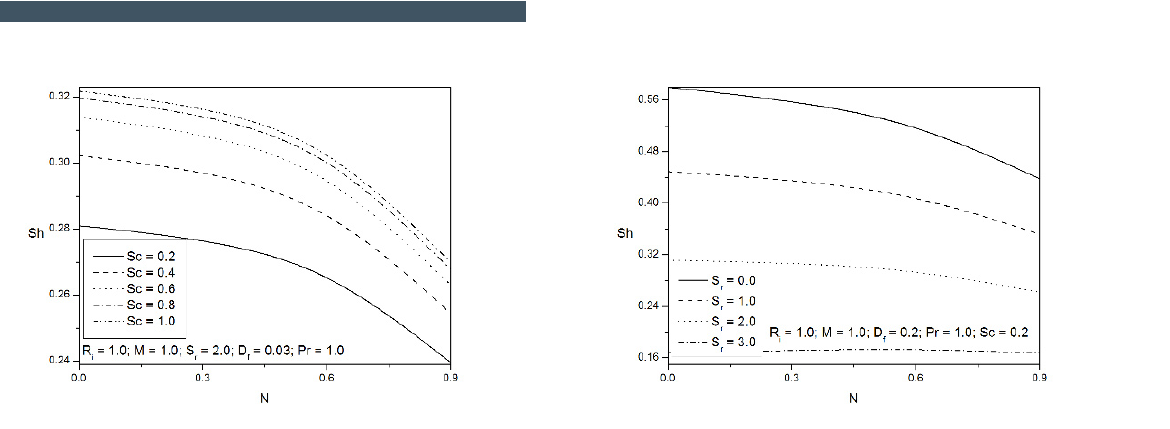
Figure 13. Effect of Schmidt number Sc on Mass Transfer Rate